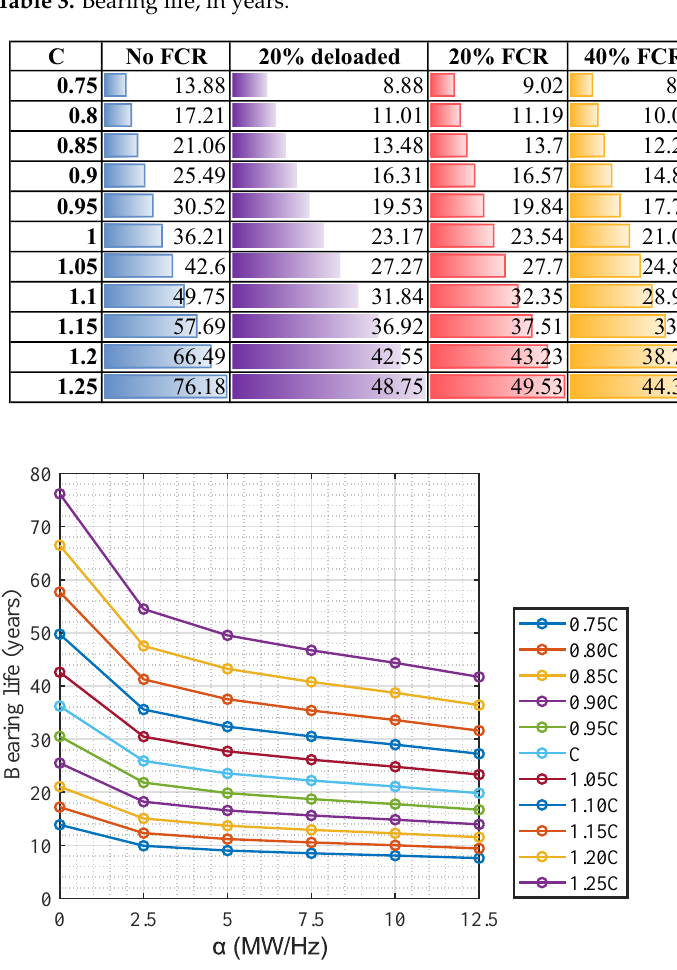
Figure 12. Bearing life vs. α for the different basic dynamic load rating